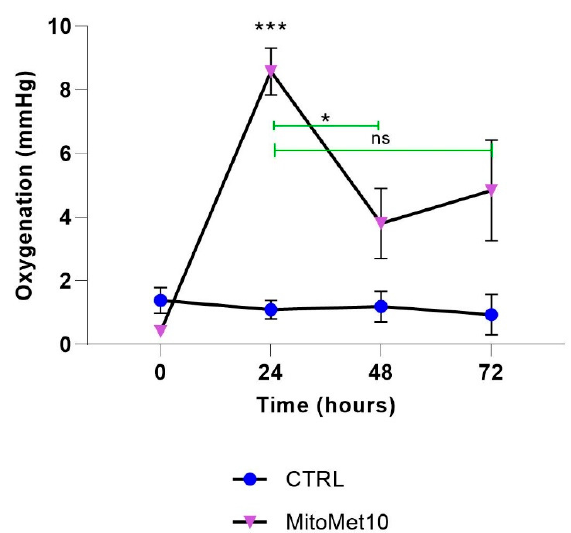
Figure 6. Effect of daily treatment with MM10 (2 mg/kg for 4 days) on tumor oxygenation as measured by EPR oximetry. Data are shown as means ± SEM, (*) p < 0.05, (***) p < 0.001, Two-way ANOVA, N = 4.